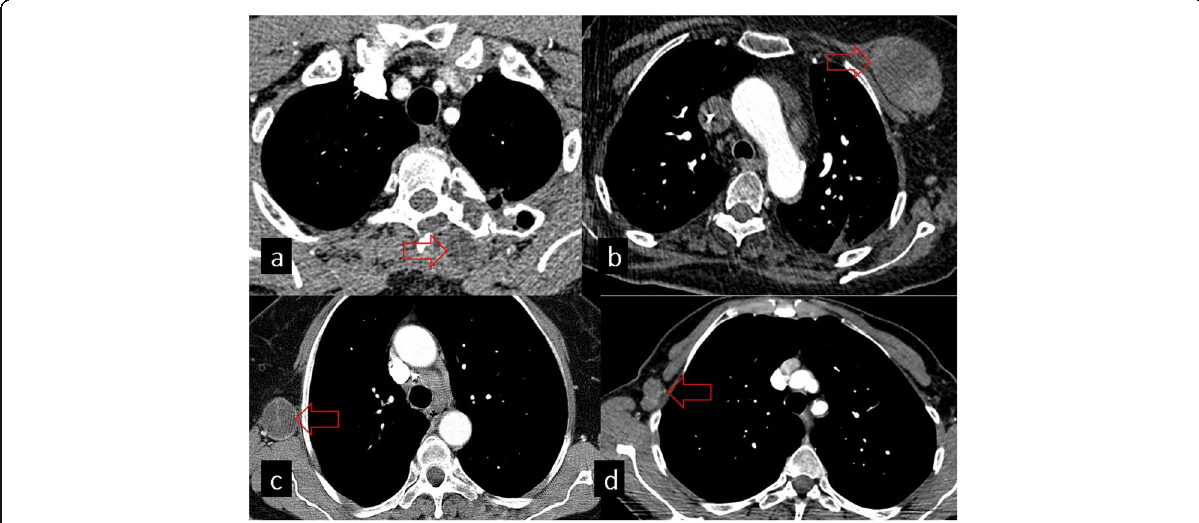
Fig. 12 Hydatid cysts in thoracic soft tissues and differential diagnosis. a Axial CT image shows left paraspinal muscle involvement of HC (red arrow). b Pectoral hematoma as a differential diagnosis of HC seen on CT image (red arrow). c HC with daughter cysts located in the right axilla seen on the axial CT image (red arrow). d Necrotic lymphadenopathy secondary to lung cancer is seen in the right